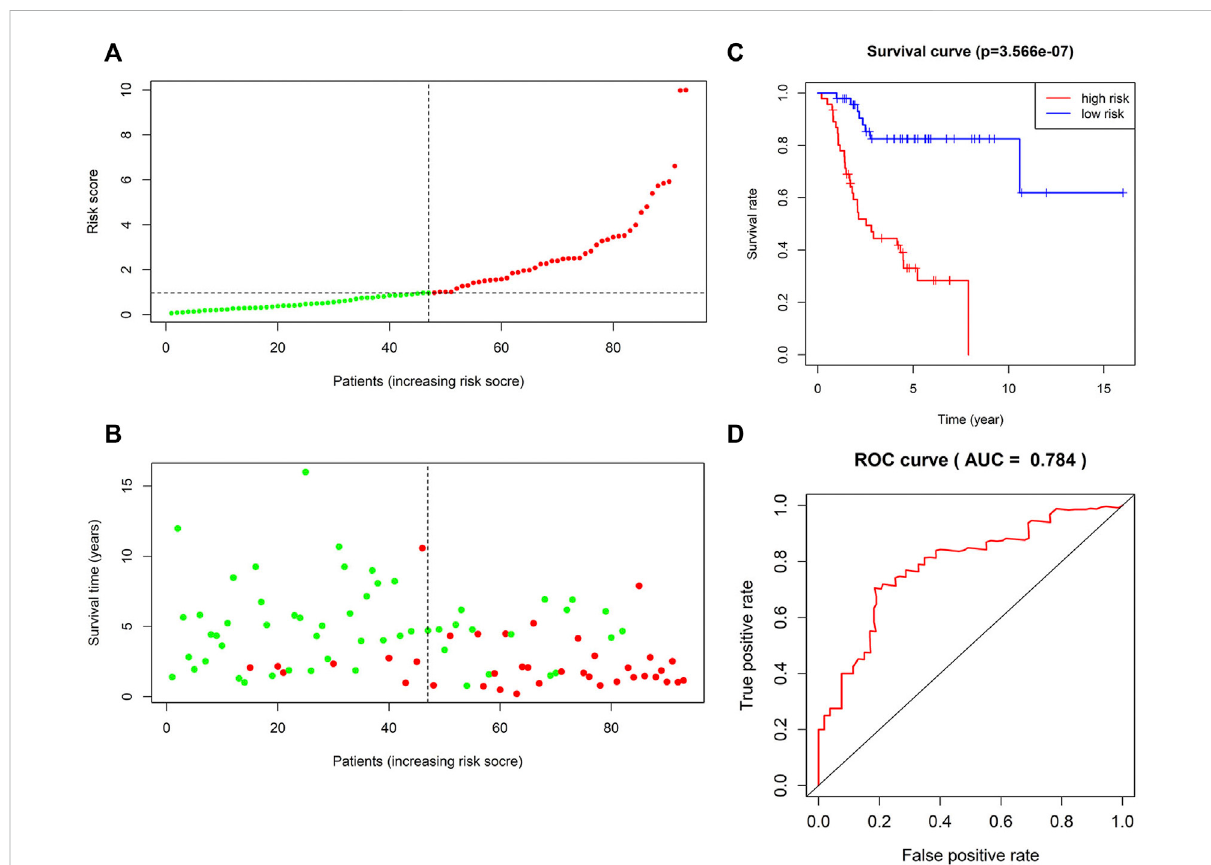
FIGURE 3 Survivalpredictionofthefour-lncRNArisksignatureforosteosarcoma. (A) Riskscoredistribution.Greenpointsrepresentlow-risk patients,and redpointsrepresenthigh-riskpatients. (B) Distributionofsurvivaltimeandsurvivalstatusofpatientsinhigh-riskandlow-riskgroupsaccordingtothe signature. Green points represent livingpatients, and redpoints represent deceased patients. (C) Kaplan – Meier curves oftheoverall survivalofhigh- risk and low-risk osteosarcoma patients based on the four-lncRNA signature. (D) Receiver operating characteristic (ROC) curve analysis of the four-lncRNA signature for predicting 5-year survival of patients with